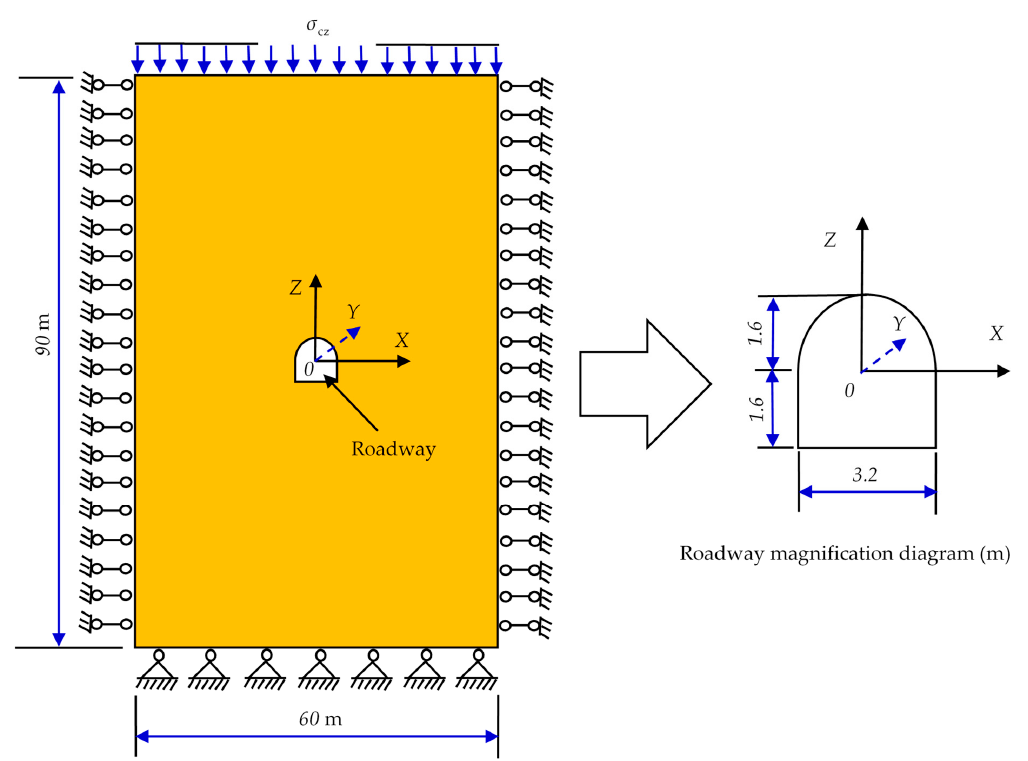
Figure 6. The boundary condition of numerical calculation model and roadway geometric size.